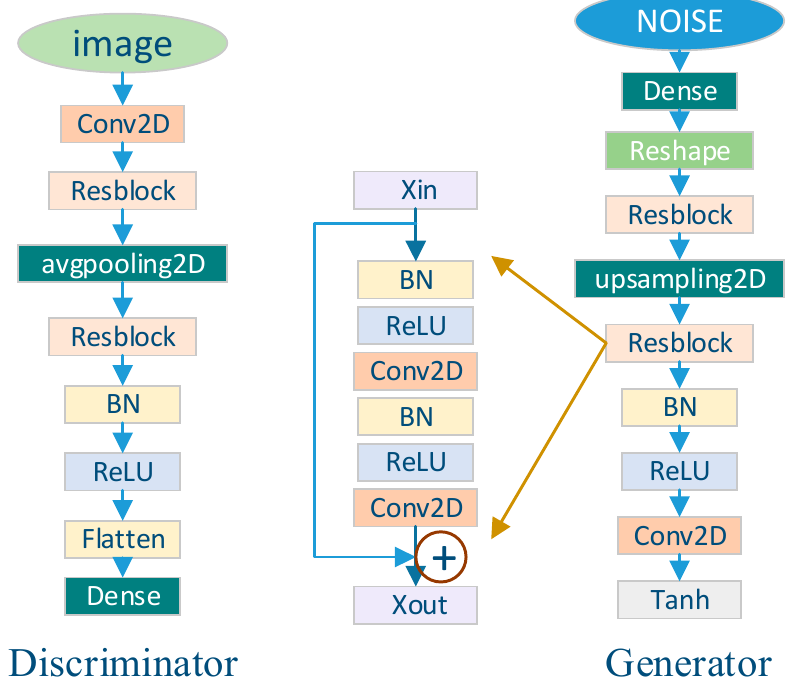
Figure 7. Residual Convolutional GAN structure.